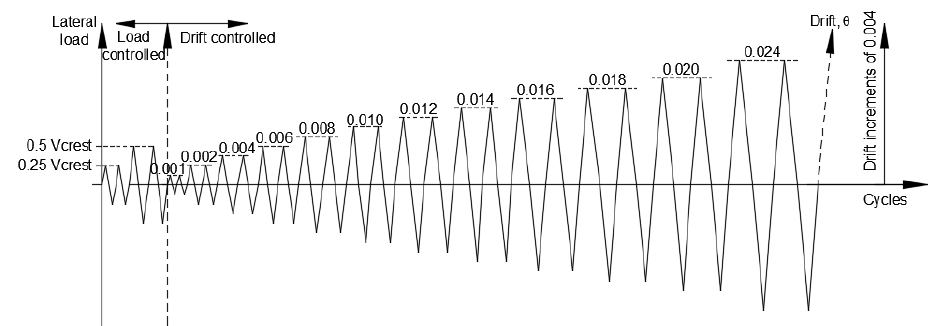
Figure 6. Lateral load sequence.